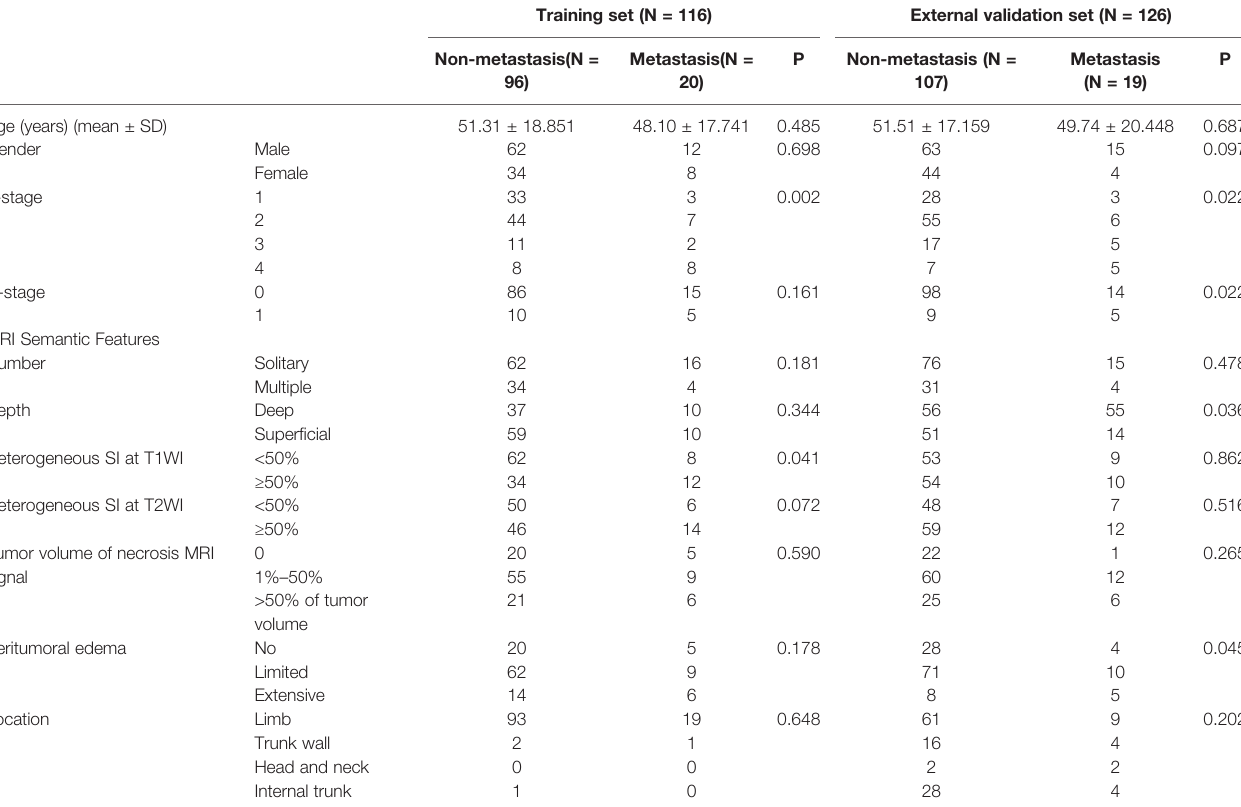
TABLE 1 | Patient ’ s Clinical information and MRI semantic features between non-metastasis and metastasis group in the training and external validation